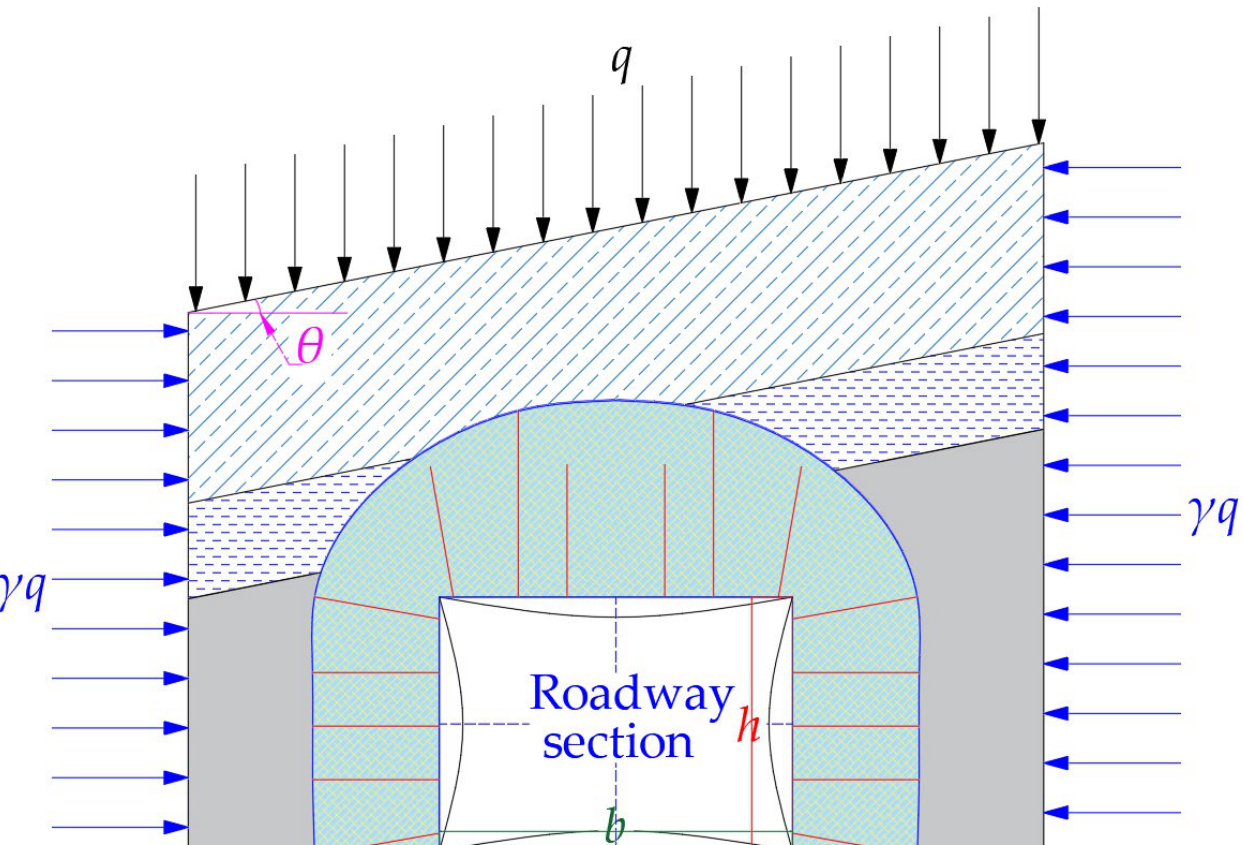
Figure 8. Stress of the mining roadway in the inclined coal seams.